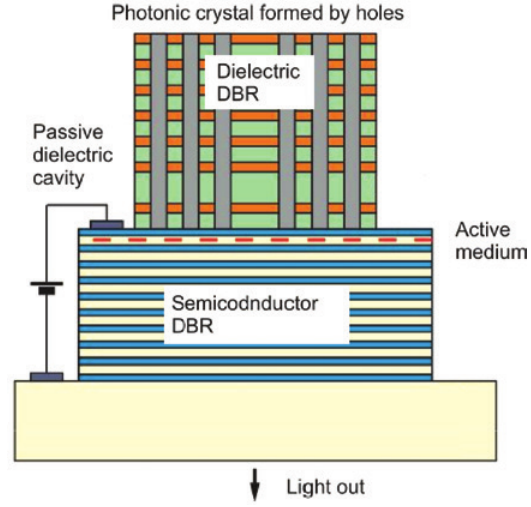
Figure 6: An example of InP-based VCSEL design with a dielectric DBR following Ref.